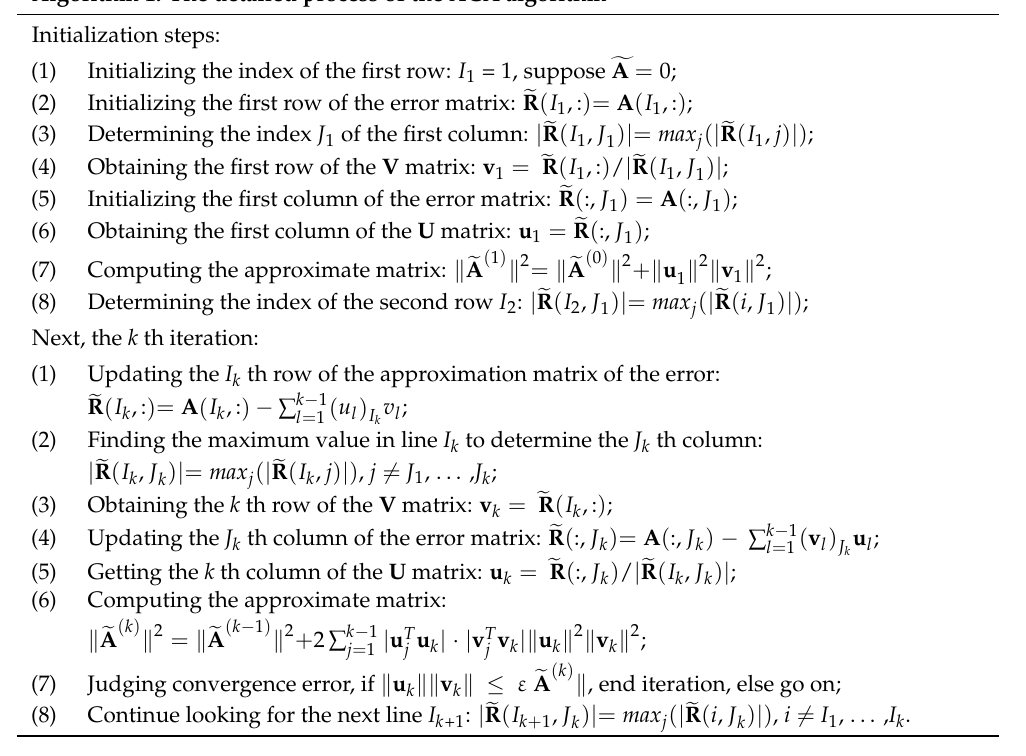
Algorithm 1. The detailed process of the ACA